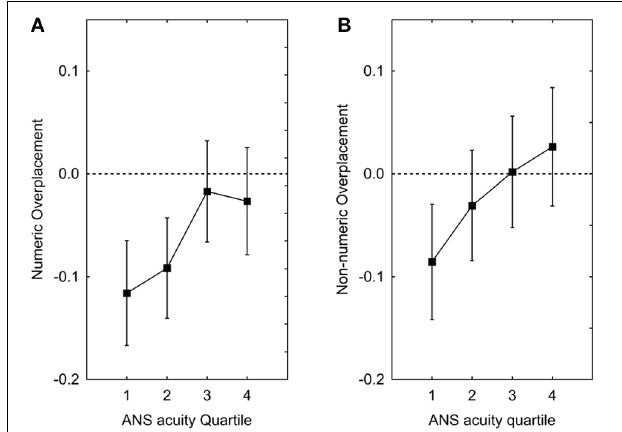
FIGURE 4 | Placement plotted as function of ANS Acuity Quartile for the numeric (A) and non-numeric measure (B). Square symbols depict means adjusted for the effects of potentially confounding variables (gender, age, IQ, and proportion of correct answers).